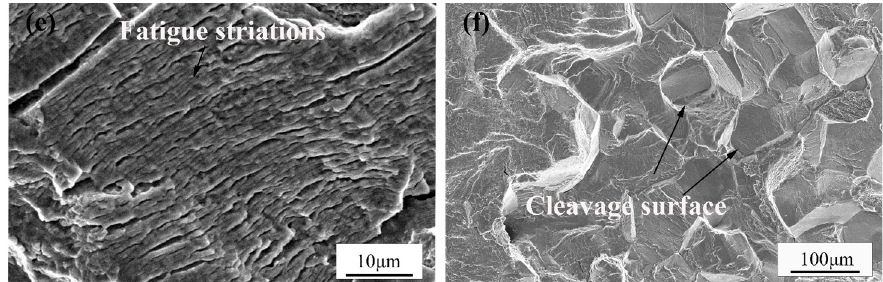
Figure 8. Micrographs of fatigue fracture of the welded joint of TC17 titanium alloy, ( a ) overall shape of a single pore of fatigue fracture, ( b ) morphology of internal single pore fatigue initiation area ( σ a = 400 MPa,N = 1.0860 × 10 7 ) , ( c ) overall pore morphology of fatigue fracture, ( d ) internal pore cluster of fatigue initiation area ( σ a = 360 MPa,N f = 2.1414 × 10 6 ) , ( e ) fatigue striations of fatigue fracture, ( f ) cleavage surface of the TC17 EBW joint.